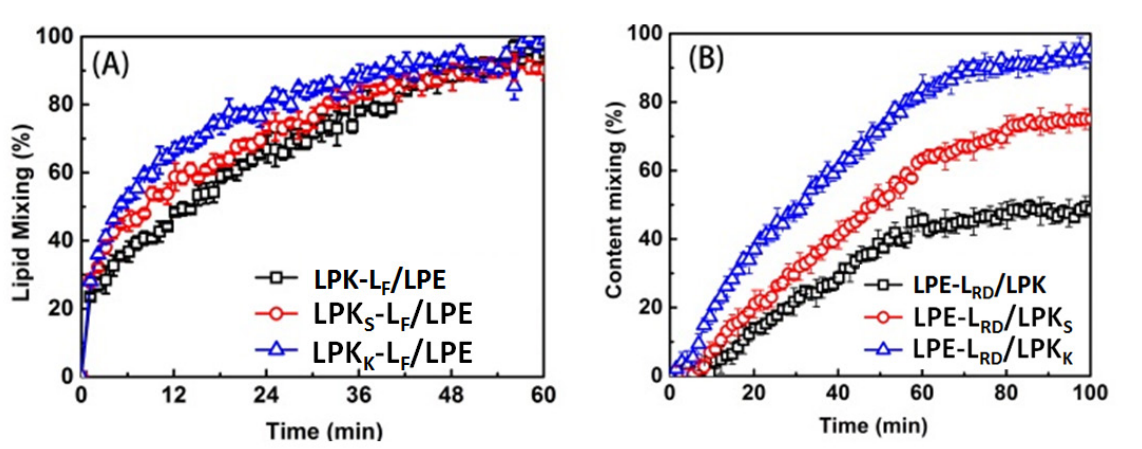
(and derivatives) liposomes with F